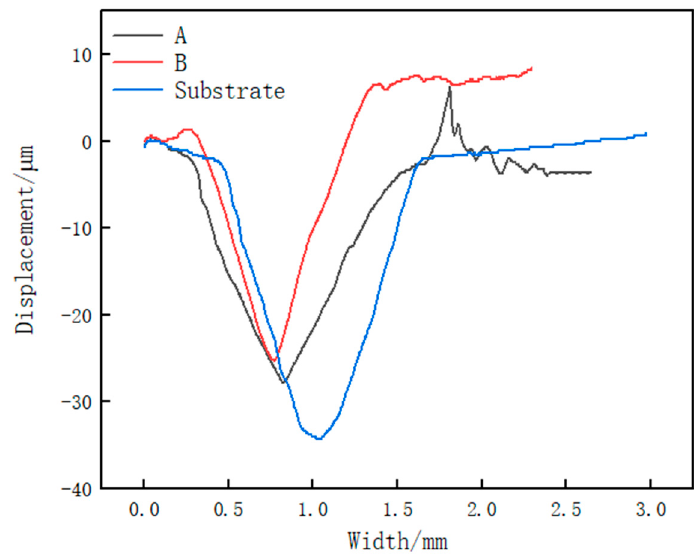
Figure 11. Wear profile of cladding layer and substrate.